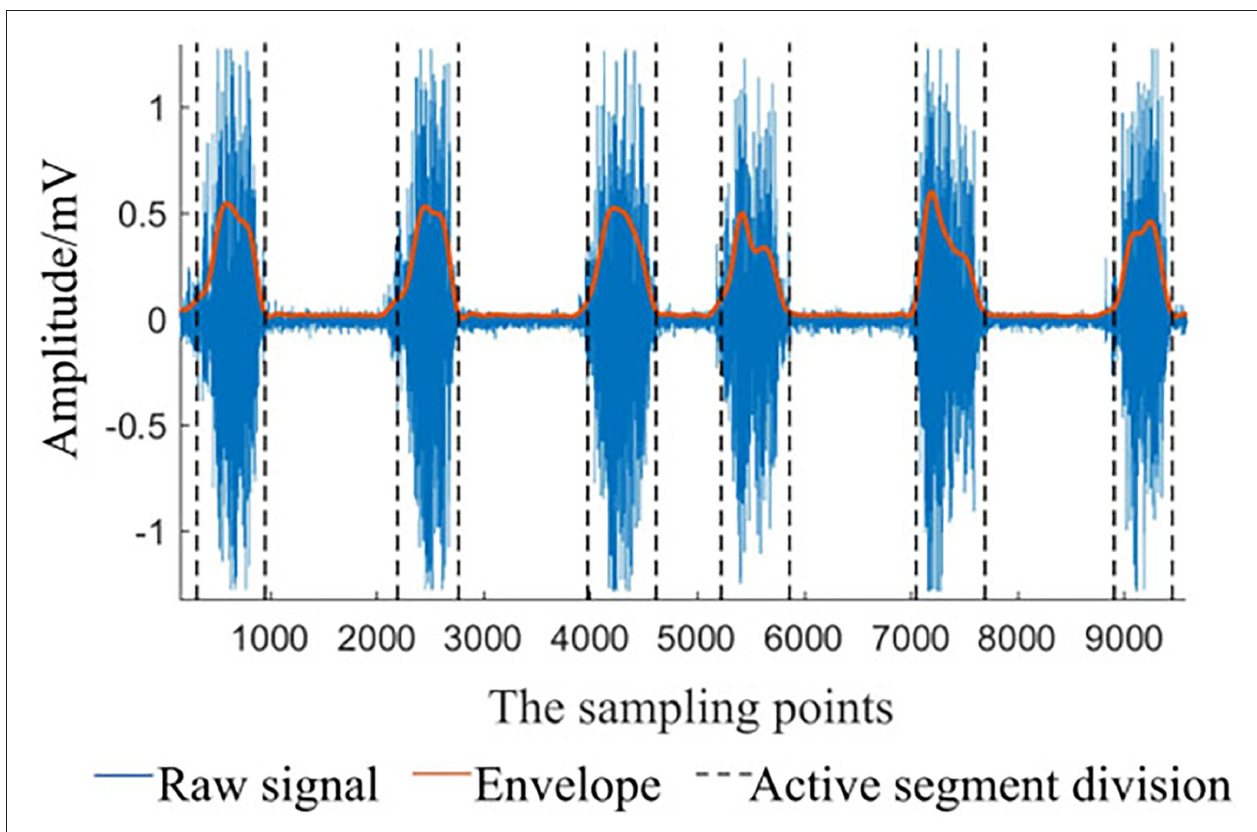
FIGURE 6 | Envelope and activity